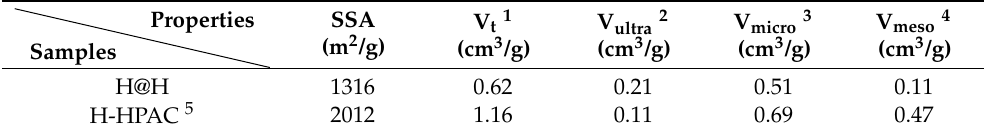
Figure 4. Nitrogen adsorption–desorption isotherm of H@H composite material collected by an accelerated surface area and porosimetry system at 77 K. Inset shows the pore size distribution curve determined by the 2D-NLDFT model. Table 1. Textural properties of H@H composite material and H-HPAC.